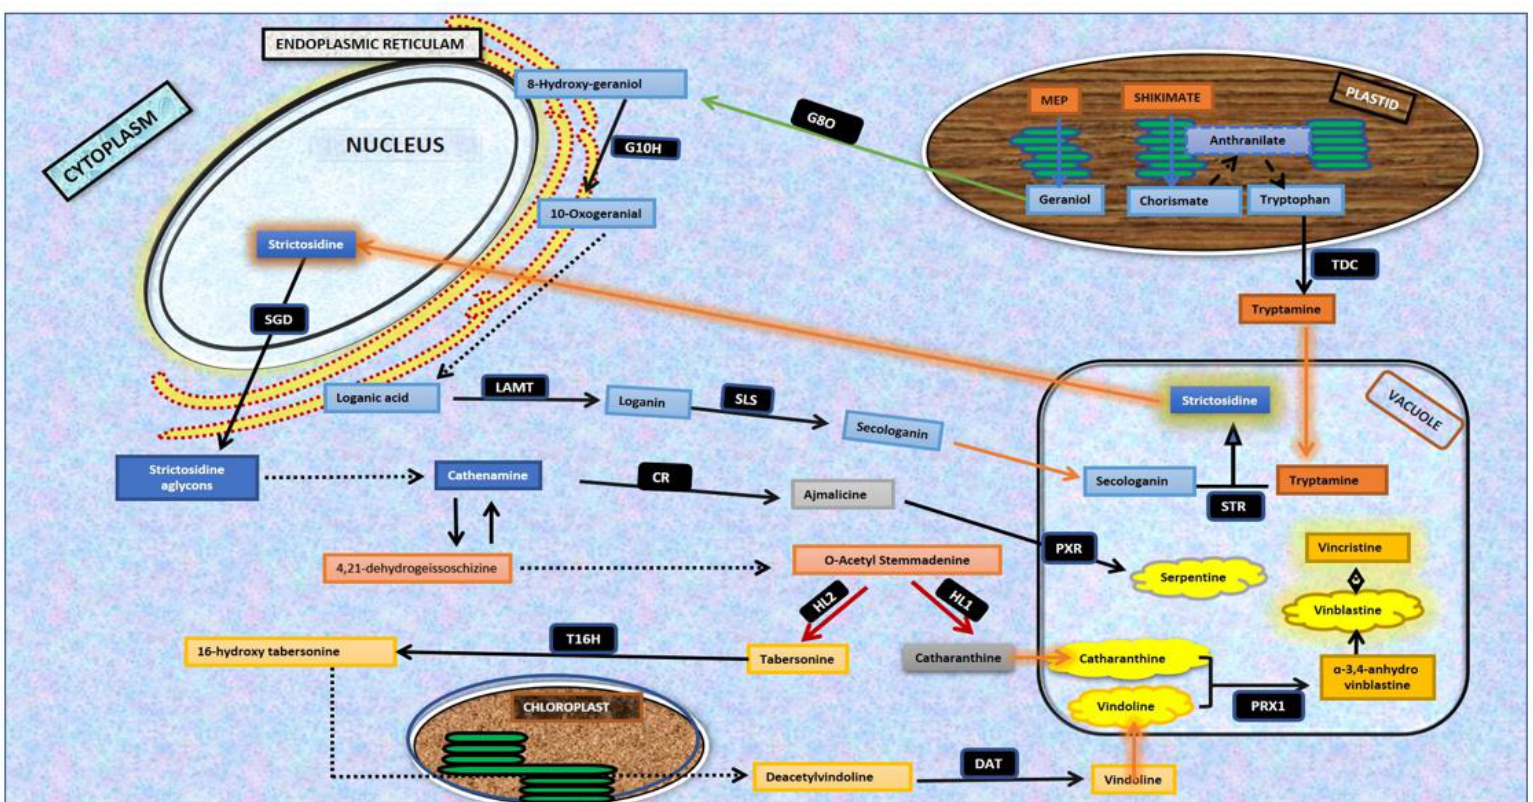
Figure 1. Schematic representation of monoterpenoid indole alkaloid (MIA) pathway in C. roseus . The following pathway genes/intermediates involved in MIA biosynthesis are shown as follows: G8O-, geraniol 8-oxidase; G10H-, geraniol 10-hydroxylase; LAMT-, loganic acid O-methyltransferase; TDC , tryptophan decarboxylase; SLS, secologanin synthase; STR, strictosidine synthase; SGD , strictosidine- β -D-glucosidase; CR , cathenamine reductase; HL1, HL2 , hydrolase-type enzymes; T16H , tabersonine 16 hydroxylase; DAT , desacetoxyvindoline-4-O-acetyltransferase; PRX1 , α -3 ′ ,4 ′ anhydrovinblastine synthase; PRX , peroxidase. Representative symbols: arrows; highlighted straight arrow: strictosidine transport from the vacuole to nucleus; straight arrow: direct enzymatic reaction; broken arrow: multistep enzymatic reactions with stable/unstable intermediates; double-ended arrows: isomerization steps; pathway genes are represented in black squares, intermediate molecules are represented in blue, orange and grey square boxes, and important metabolites are represented in clouds.